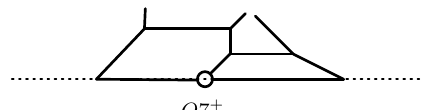
Figure 12. A 5-brane web for Sp(2) π + 1 Adj or SU(3) 3